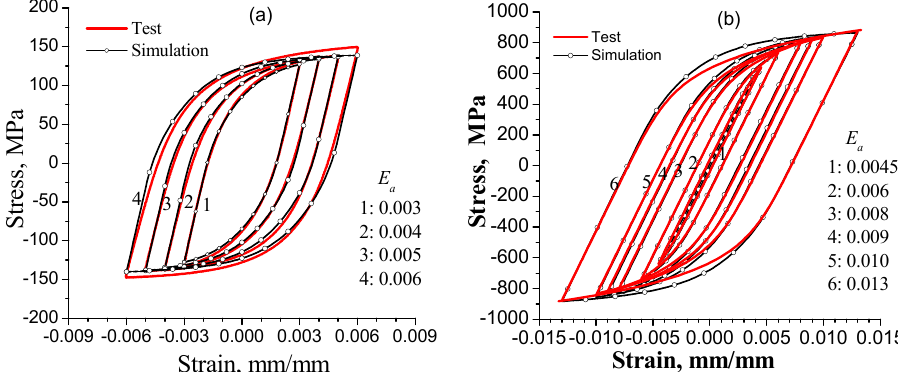
Figure 2. Results for steady and symmetric tensile-compressive hysteresis loops from simulations and experiments: ( a ) for copper T2; ( b ) for superalloy GH4169.